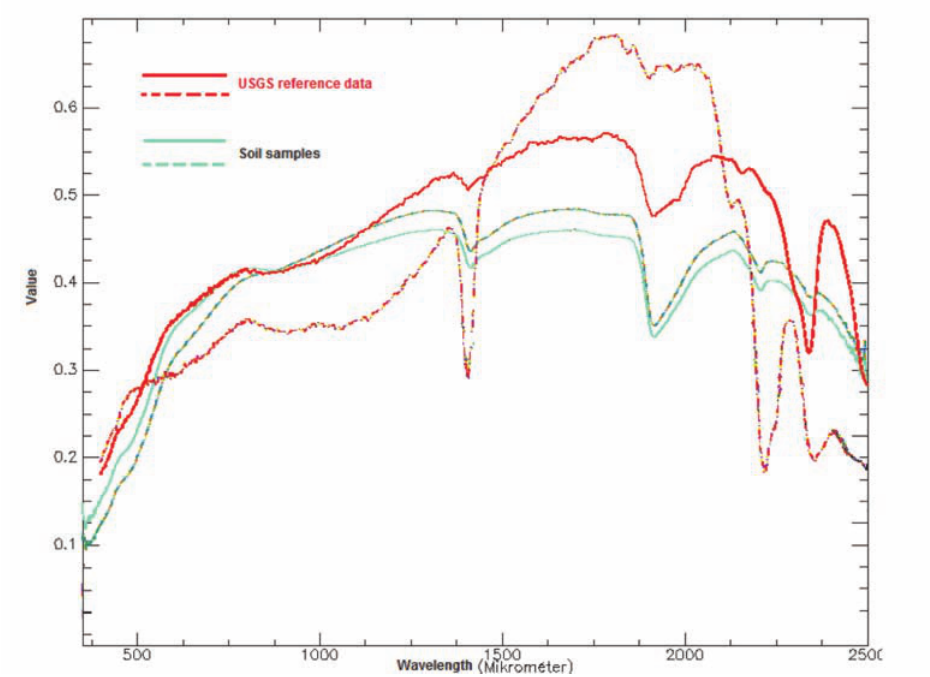
Figure 5. Spectral properties of the USGIS reference and soil sample